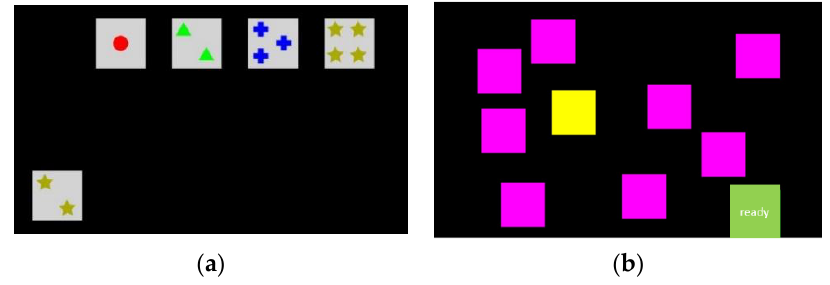
Figure 1. Stimulus presentation for Wisconsin Card Sorting Test ( a ) and Corsi block test ( b